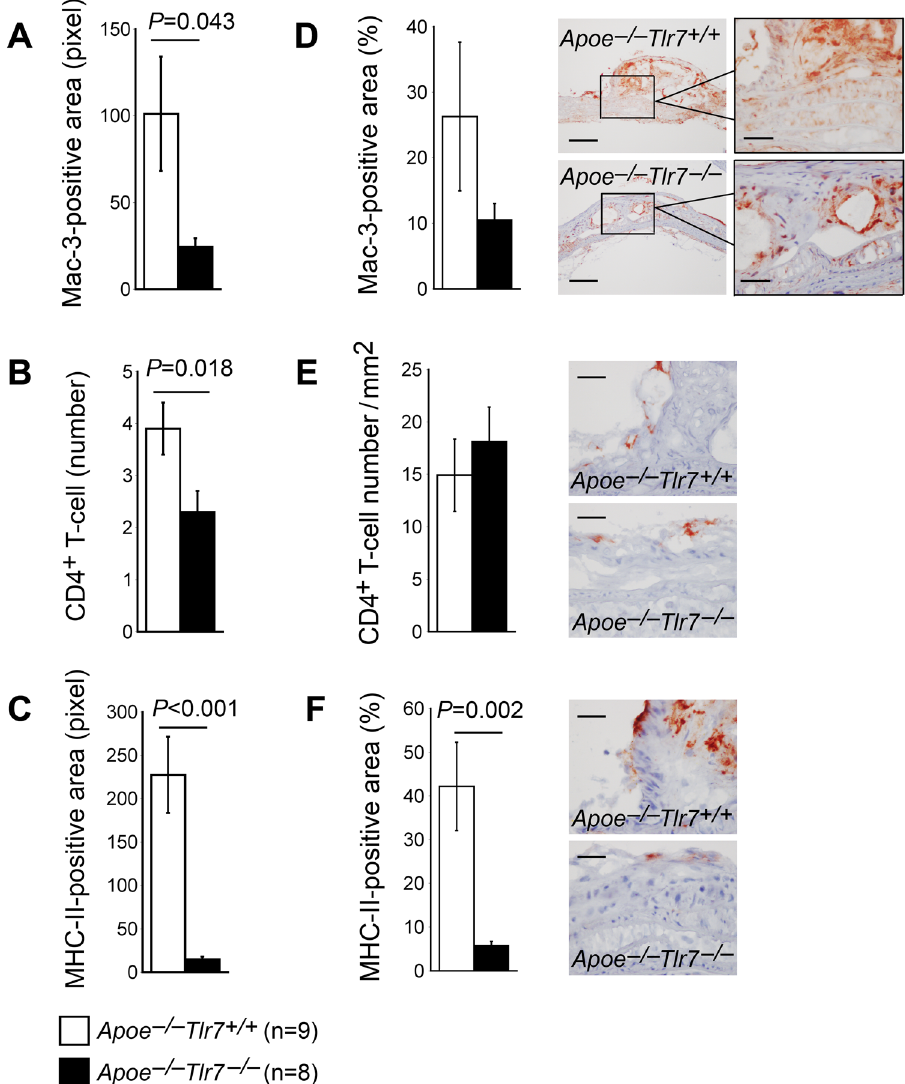
Figure 3. TLR7 deficiency and aortic arch atherosclerotic lesion inflammatory cell accumulation in male Apoe − / − mice. ( A) Mac-3-positive area in pixel. ( B) Lesion CD4 + T-cell number. ( C ) Lesion MHC class-II- positive area in pixel. ( D ) Mac-3-positive area versus total lesion area in percentage. Representative images are shown to the right. Scale: 200 µ m, inset scale: 100 µ m. ( E ) Lesion CD4 + T-cell number per mm 2 . Representative images are shown to the right. Scale: 100 µ m. ( F ) Lesion MHC class-II-positive area versus total lesion area in percentage. Representative images are shown to the right. Scale: 100 µ m. Numbers and genotypes of mice are indicated in the